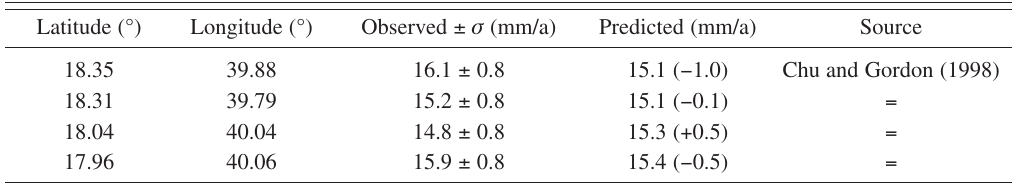
Table IIa-i ( continued )